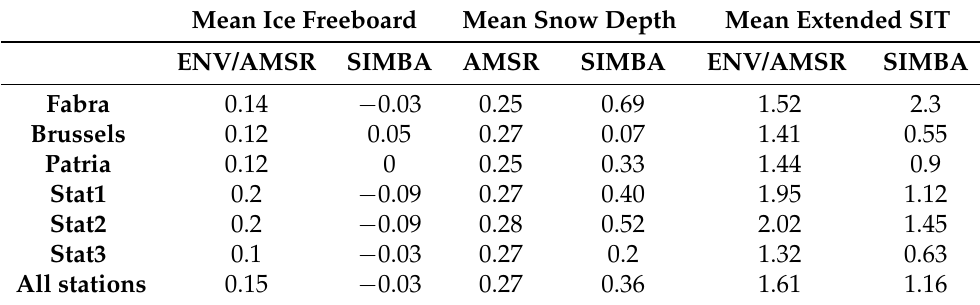
Table 2. Mean sea ice freeboard and snow depth along each transect line of the SIMBA campaign. The ENV/AMSR column presents the Envisat sea ice freeboard that considers AMSR data to account for the radar speed decreasing into the snow. The SIMBA “Mean extended SIT” values are SIT estimations assuming that the layer between the ice interface and the sea elevation is only constituted of